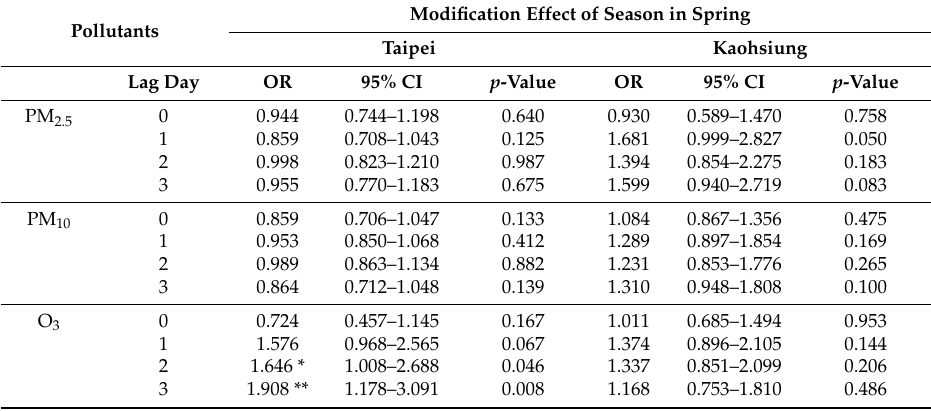
Table 4. Association between air pollution and childhood asthma in